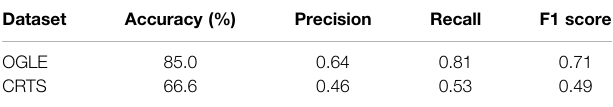
TABLE 3 | Results of classi fi cation using 1D CNN-LSTM on the OGLE and the CRTS survey light curves.